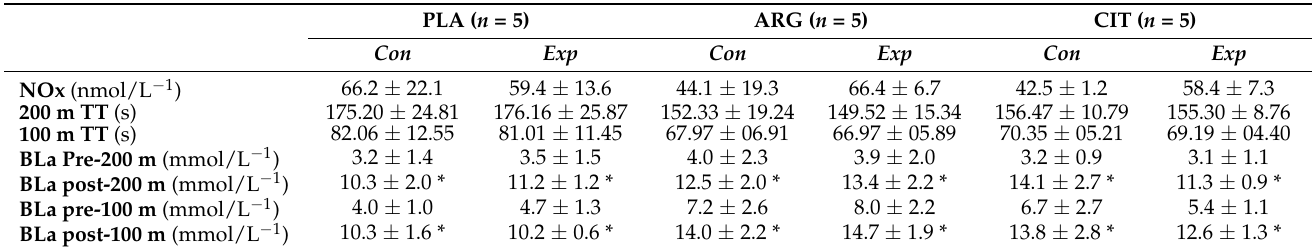
Table 1. Group mean (SD) of NOx and BLa responses after 8-day L-citrulline or L-arginine or placebo supplementation. PLA, placebo; ARG, L-arginine; CIT, L-citrulline; Con, control trial; Exp, experimental trial; BLa, blood